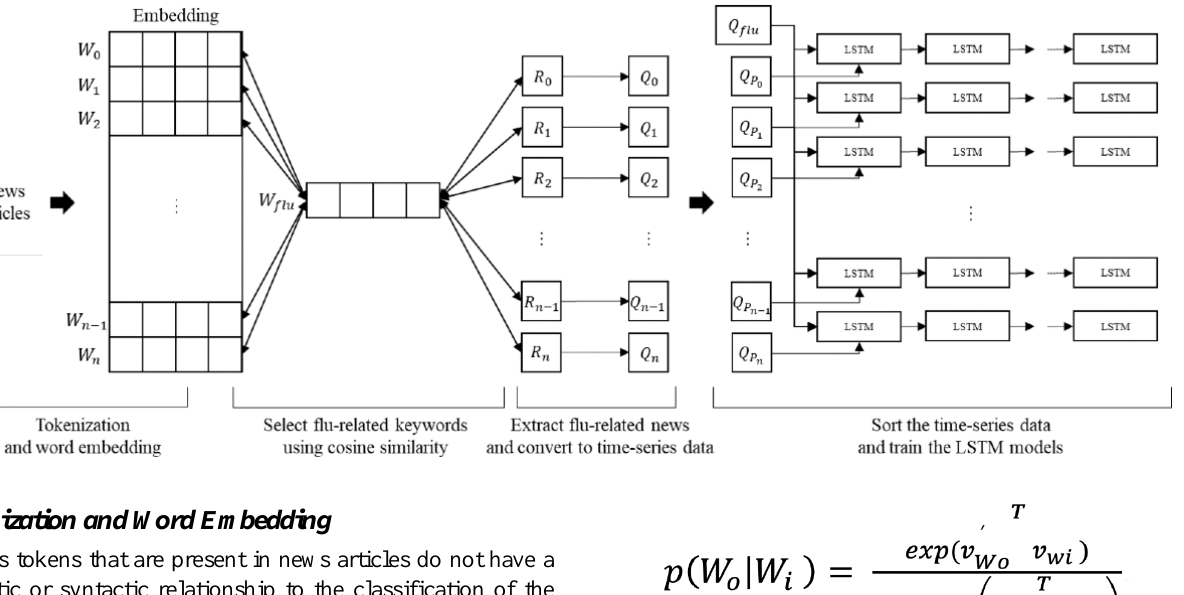
Figure 1. System architecture. LSTM: long short-term